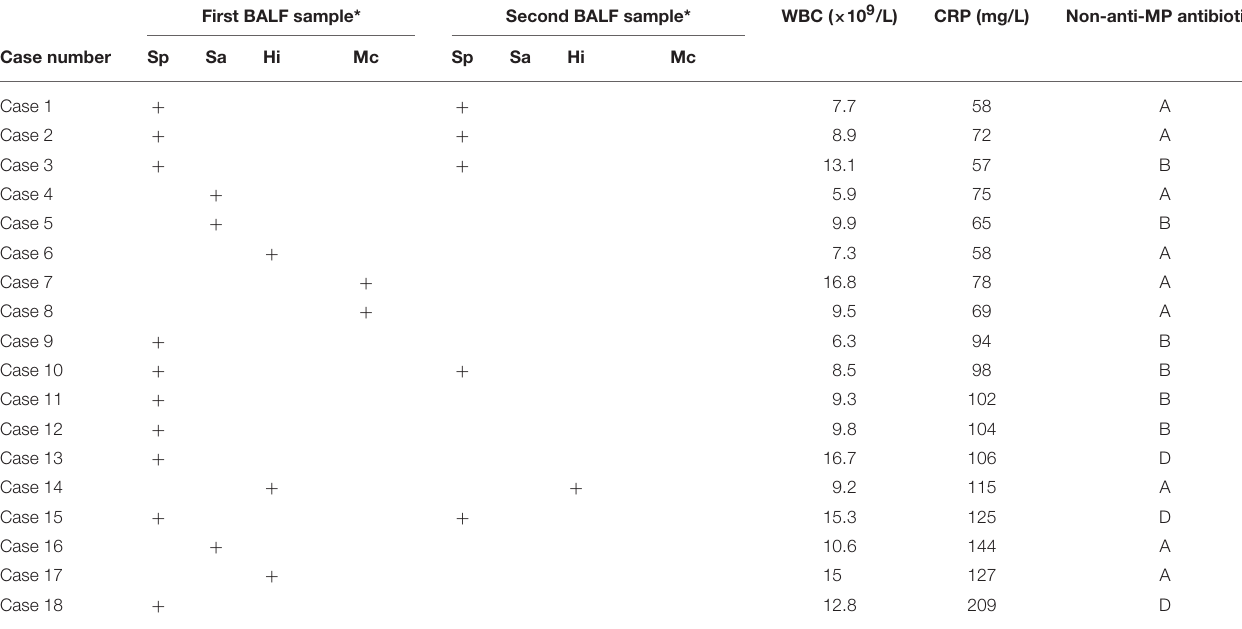
TABLE 1 | Culture results and clinical characteristics of 18 culture-positive RMPP patients. First BALF sample*